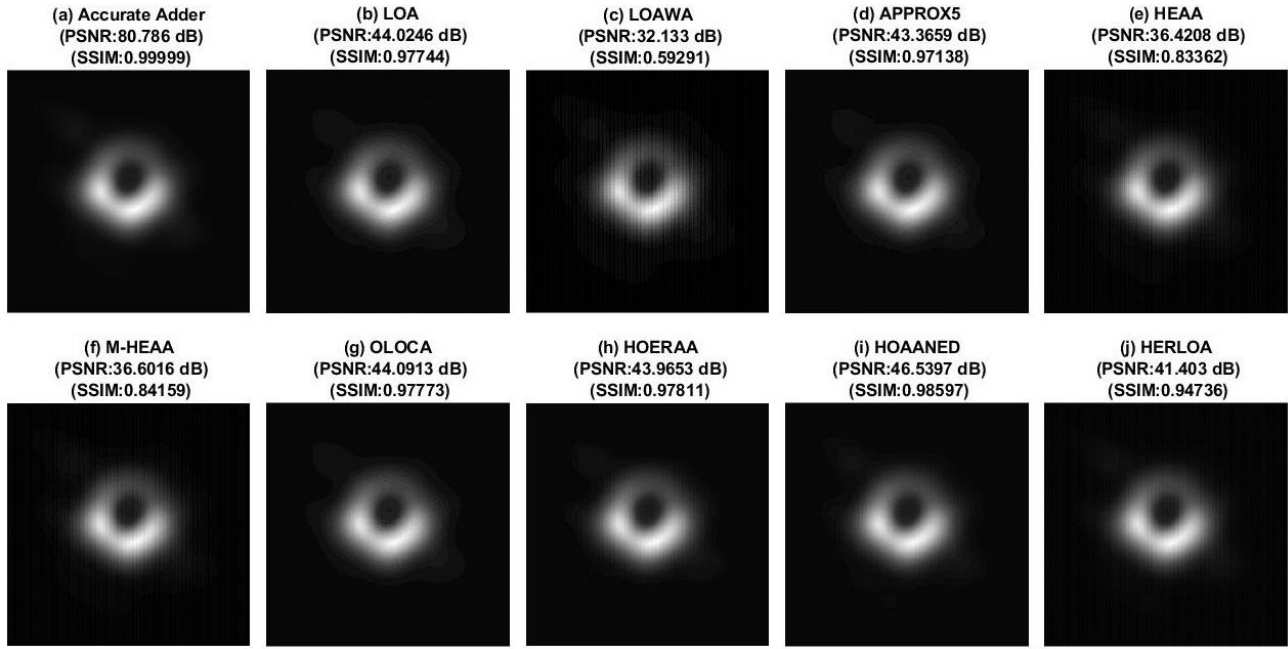
Figure 9. Black Hole image compressed using accurate adder and different approximate adders, with the approximate adders having a 10-bit inexact part.